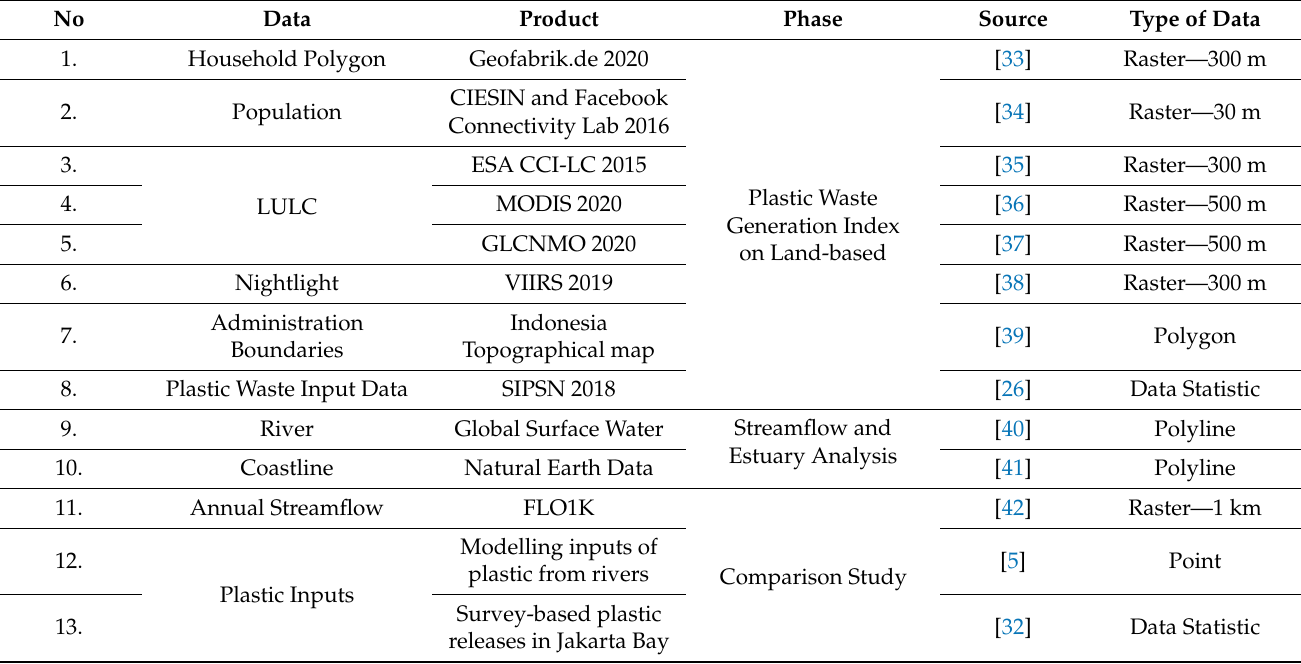
Table 1. Data used in this research